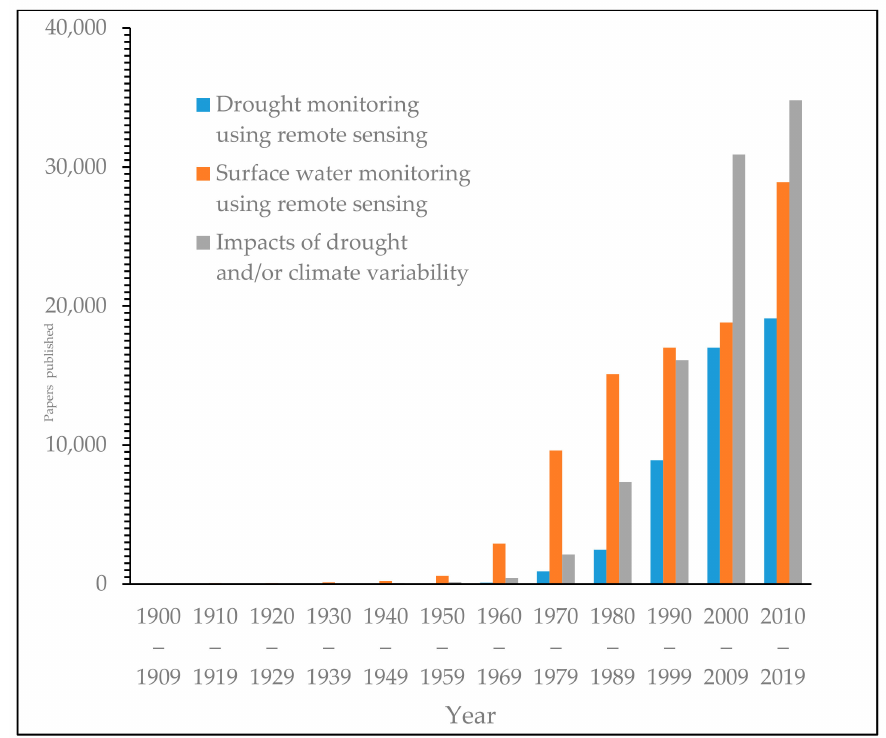
Figure 1. Number of journal article publications on drought monitoring using remote sensing, surface water monitoring using remote sensing, and impacts of drought and / or climate